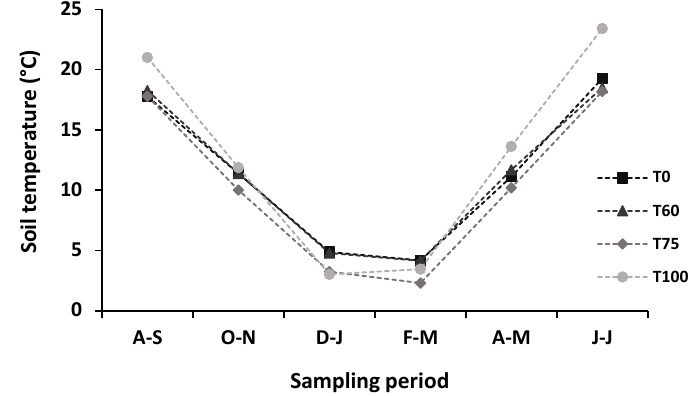
Figure 4. Average soil temperature (0–10 cm) in each sampling period and for each treatment.